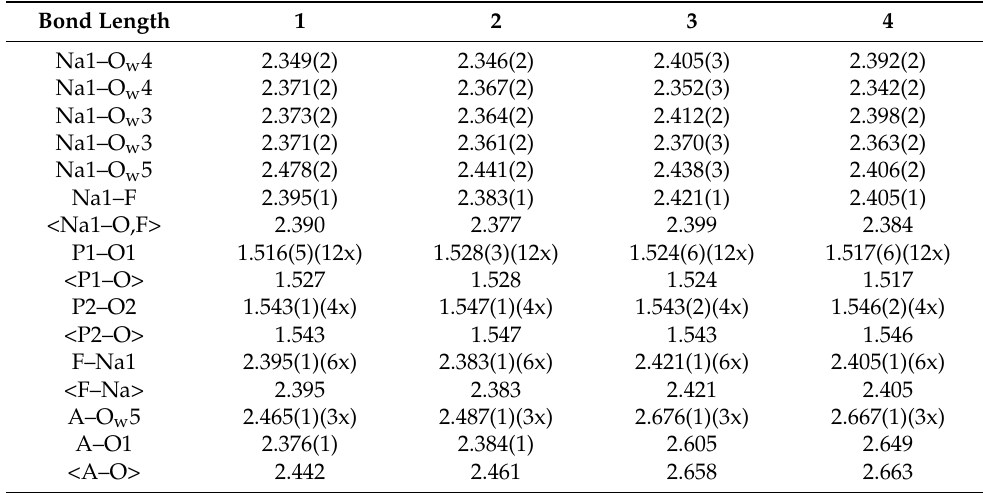
Table 3. Selected bond lengths (Å) in the crystal structures of natrophosphate (1—room temperature,